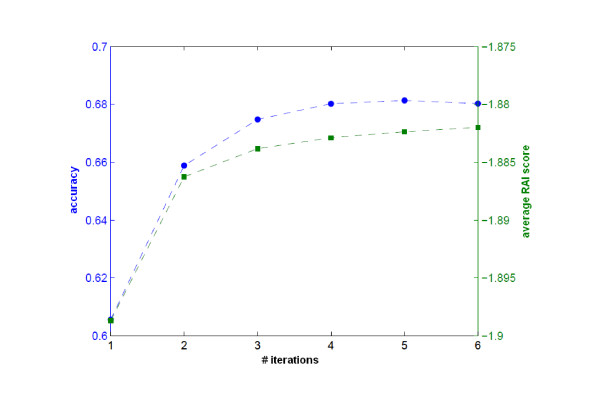
Iterative refinement. The performance increase with iterative refinement is illustrated using the same dataset and experiment setup with [24] for the fragments of length 400 bp. Left y-axis and blue curve: The increase in the percent of correct assignments with iterative refinement. Right y-axis and green curve: The increase and saturation in the average relative abundance index scores.